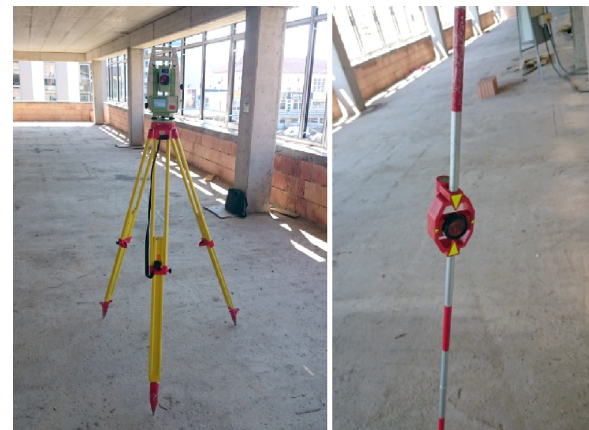
Figure 6. Leica Viva TS15 nd Leica GMP111 with a stake